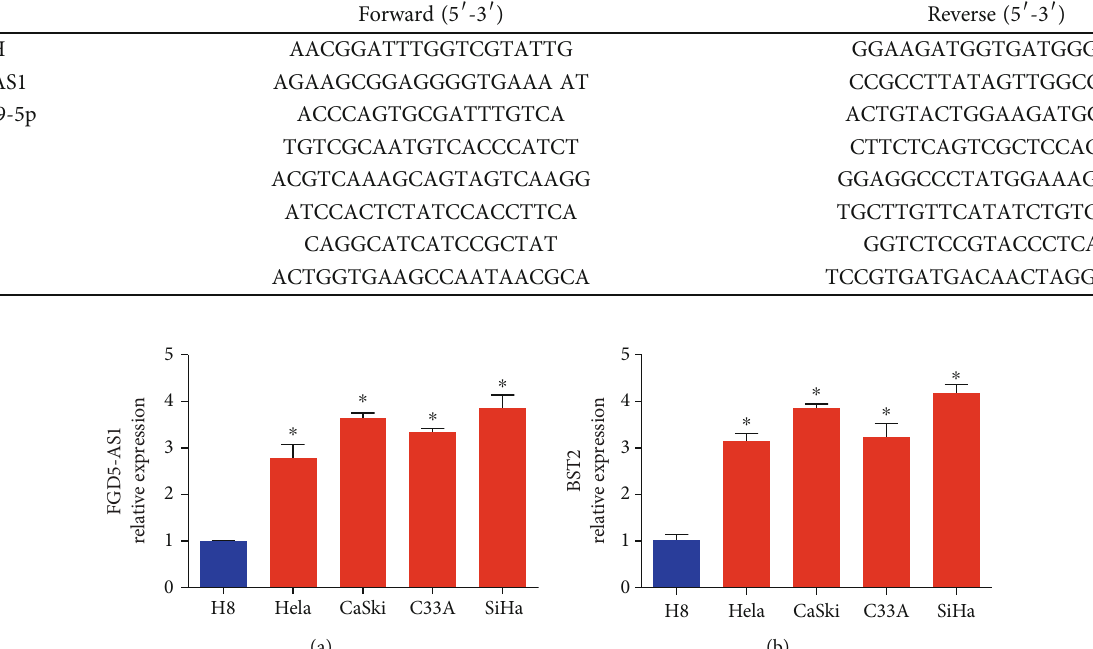
Table 1: Primers for real-time PCR.